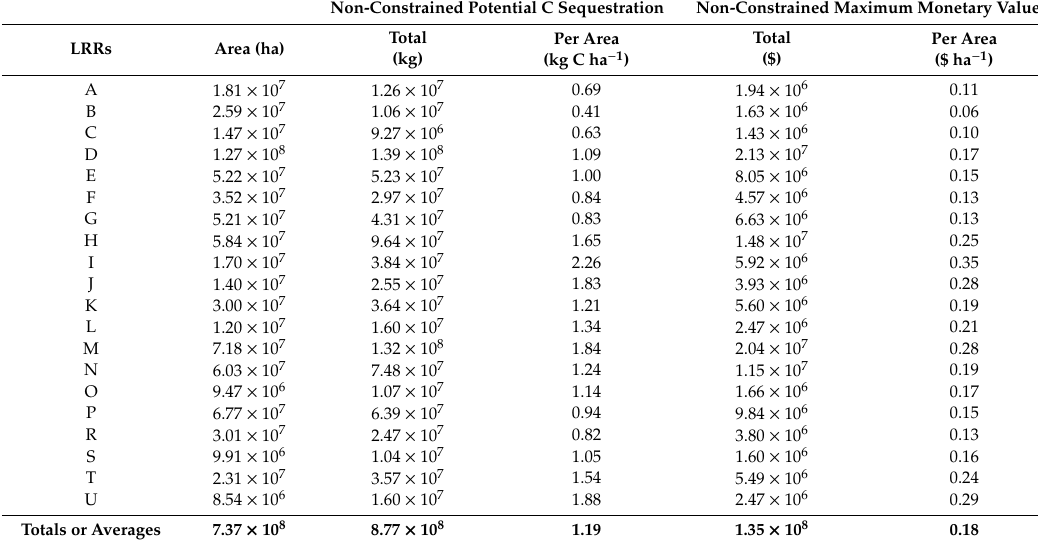
LRR abbreviations: A = Northwestern Forest, Forage and Specialty Crop Region; B = Northwestern Wheat and Range Region; C = California Subtropical Fruit, Truck, and Specialty Crop Region; D = Western Range and Irrigated Region; E = Rocky Mountain Range and Forest Region; F = Northern Great Plains Spring Wheat Region; G = Western Great Plains Range and Irrigated Region; H = Central Great Plains Winter Wheat and Range Region; I = Southwest Plateaus and Plains Range and Cotton Region; J = Southwestern Prairies Cotton and Forage Region; K = Northern Lake States Forest and Forage Region; L = Lake States Fruit, Truck, and Dairy Region; M = Central Feed Grains and Livestock Region; N = East and Central Farming and Forest Region; O = Mississippi Delta Cotton and Feed Grains Region; P = South Atlantic and Gulf Slope Cash Crops, Forest and Livestock Region; R = Northeastern Forage and Forest Region; S = Northern Atlantic Slope Diversified Farming Region; T = Atlantic and Gulf Cost Lowland Forest and Crop Region; U = Florida Subtropical Fruit, Truck, Crop, and Range Region. LRR areas from Guo et al. (2006) [17].